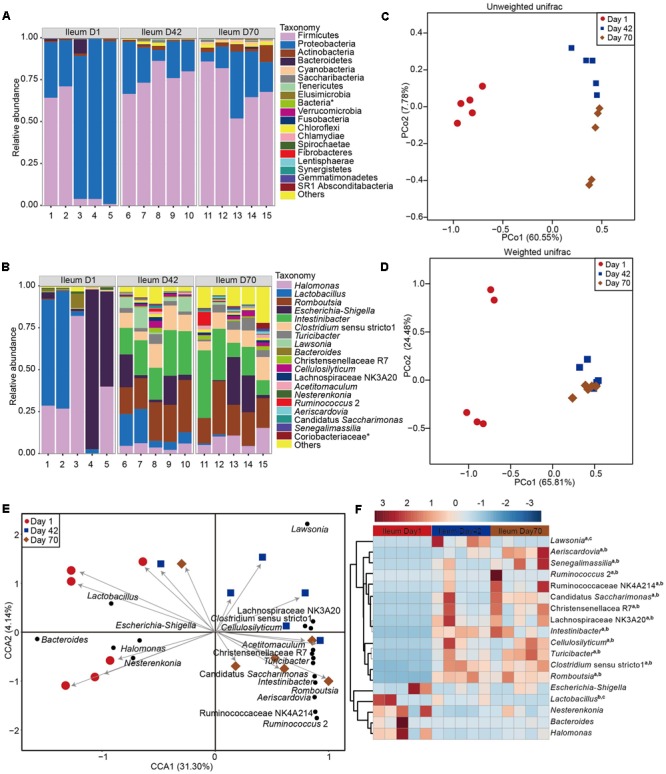
Microbial community composition in ileum of sika deer across three time points. Taxonomic composition at phylum (A) and genus level (B). Principal coordinate analysis (PCoA) of ileum microbiota based on unweighted unifrac (C) and weighted unifrac distance (D). CCA (E) and heatmap (F) showing the significant taxa of ileum across three time points. a, b, c indicate the significance between days 1 and 42, between days 42 and 70, and days 42 and 70, respectively. The asterisk means the unclassified bacteria at the family or phylum levels.